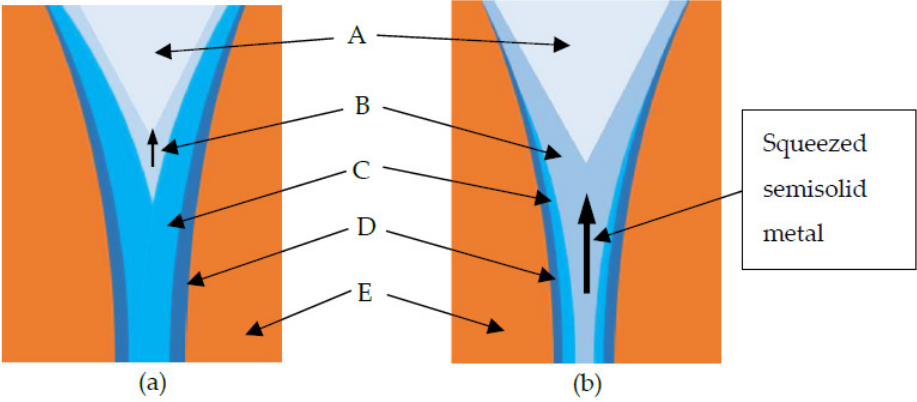
Figure 12. Schematic showing aluminum alloy between rolls: ( a ) semisolidus line is near the liqui- dus line; ( b ) semi-solidus line does not exist. A: molten metal, B: semisolid metal with poor viscosity, C: semisolid metal with excellent flowabiliy, D: solidified metal, E: copper roll.